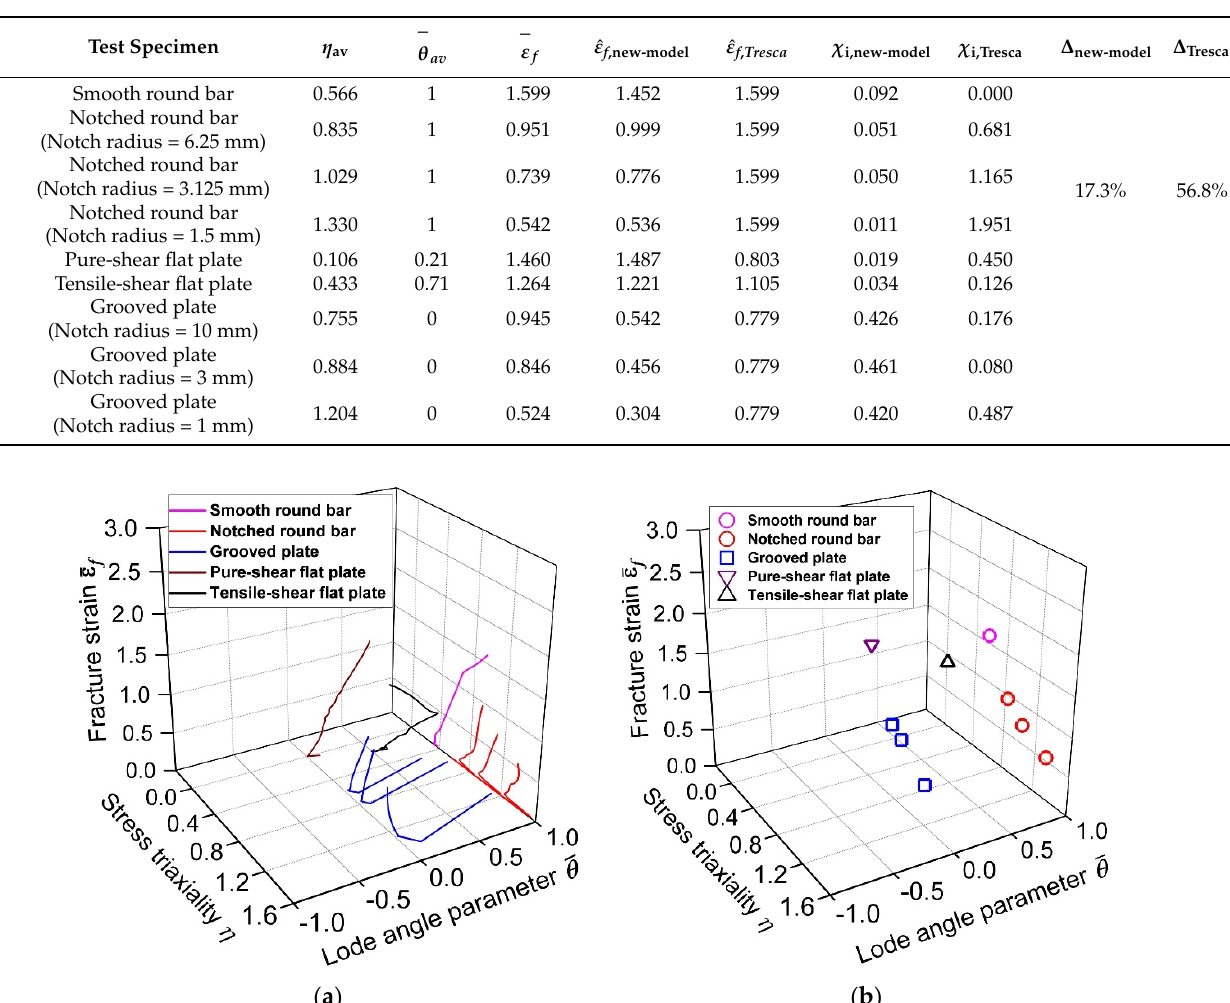
(27) where Δ denotes the average error between the predicted fracture envelope and the test data, N denotes the number of the tests, χ i denotes the relative error between the fracture surface predicted by the corresponding fracture model and the i th test data point, ˆ f ε denotes fracture strain predicted from the corresponding fracture model for the i th specimen and f ε denotes fracture strain obtained from the i th test specimen. By using Equations (26) and (27), the relative and average prediction errors obtained from the new model for the test specimens are calculated and listed in Table 3. The calculation result shows that the average prediction error obtained from the new fracture model for the